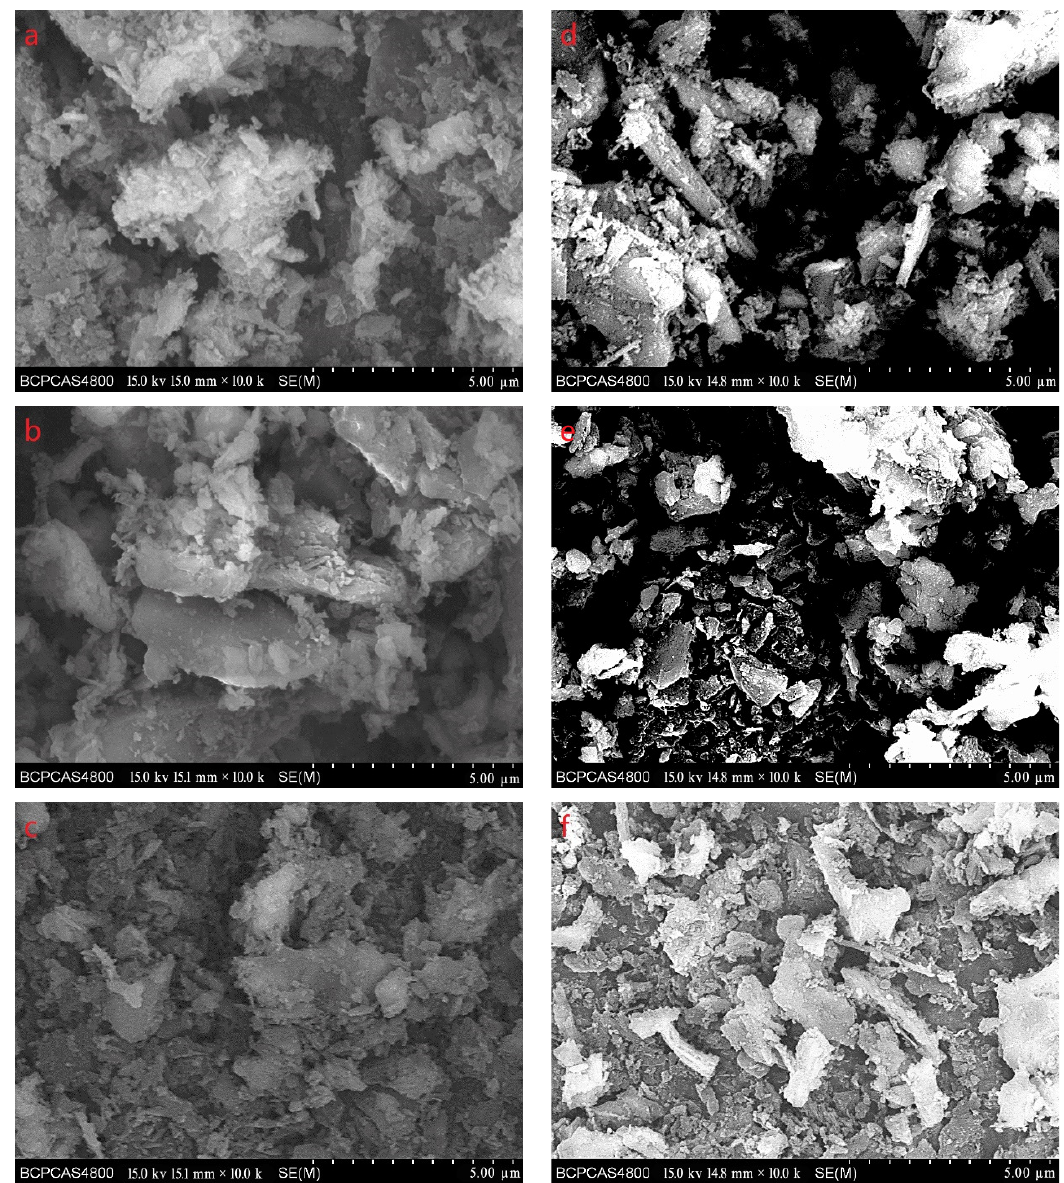
Figure 10. The SEM images of the purified products of the verification experiment. Images ( a – f ) are SEM images of 10% PP, 10% PE, 10% MF, 20% PP, 20% PE, and 20% MF experimental groups, re-